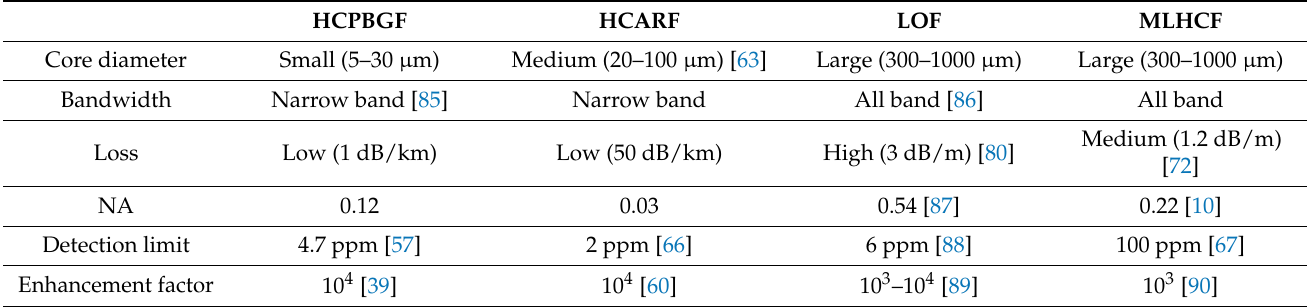
Table 2. Comparison of parameters of four optical fibers.